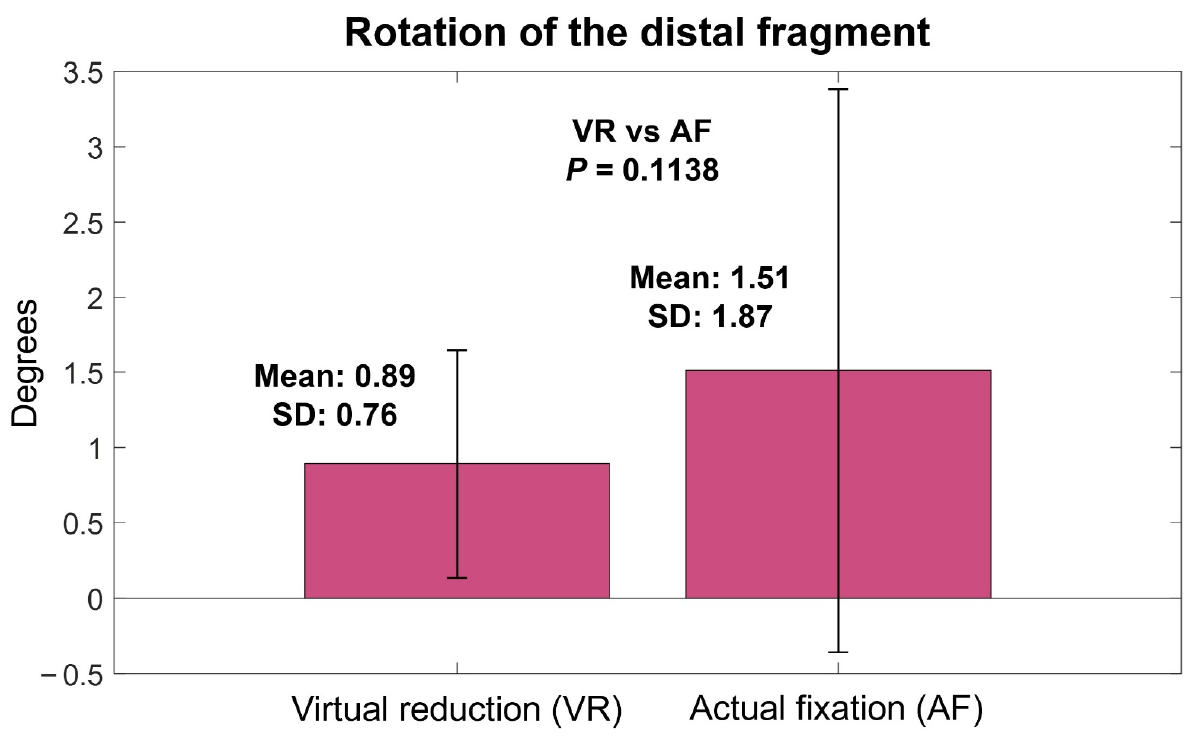
Figure 6. Rotation of virtual reduction and actual fixation models relative to intact